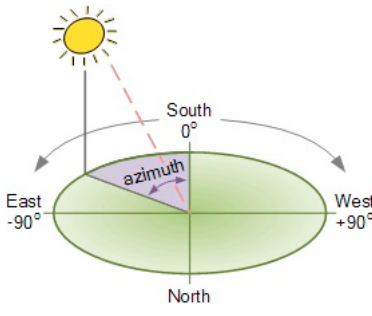
Figure 3. Definition of sun’s azimuth angle.